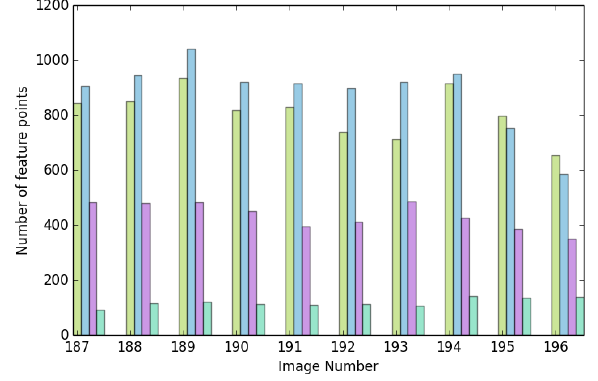
Figure 11. Number of the extracted feature points